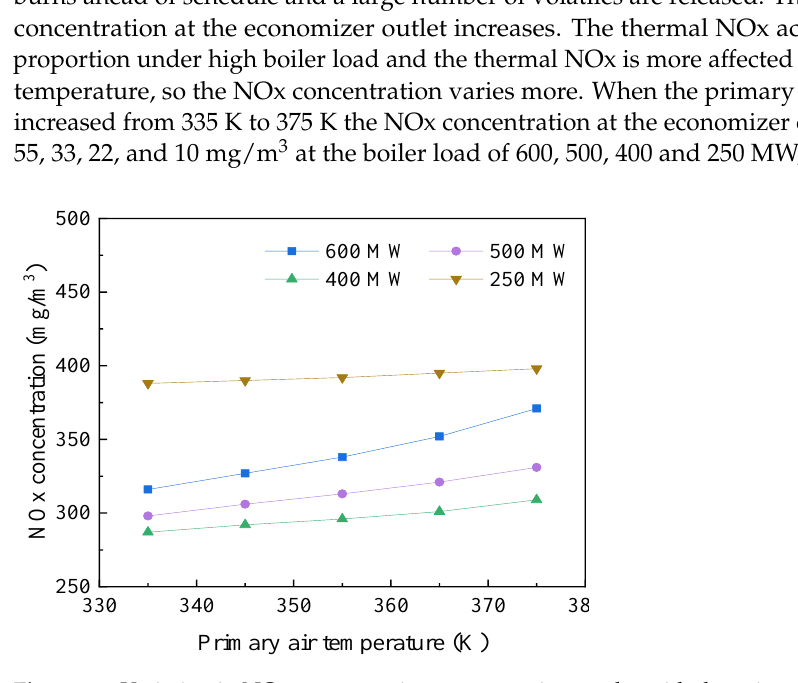
Figure 18. Variation in NOx concentration at economizer outlet with the primary air